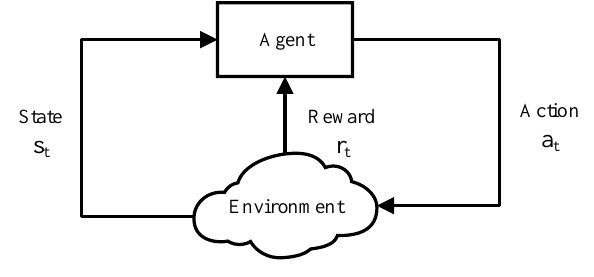
Figure 1. Learning-environment interaction.